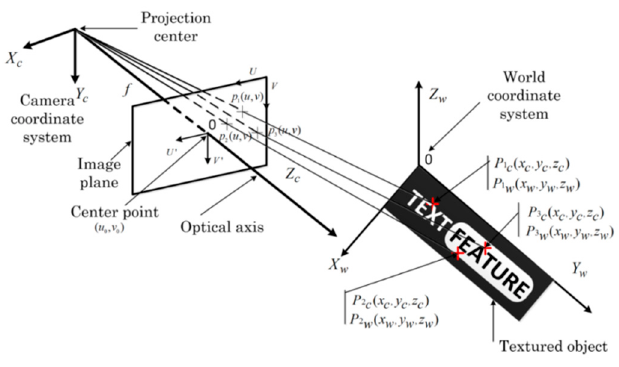
Figure 3. System layout of the pinhole camera model.